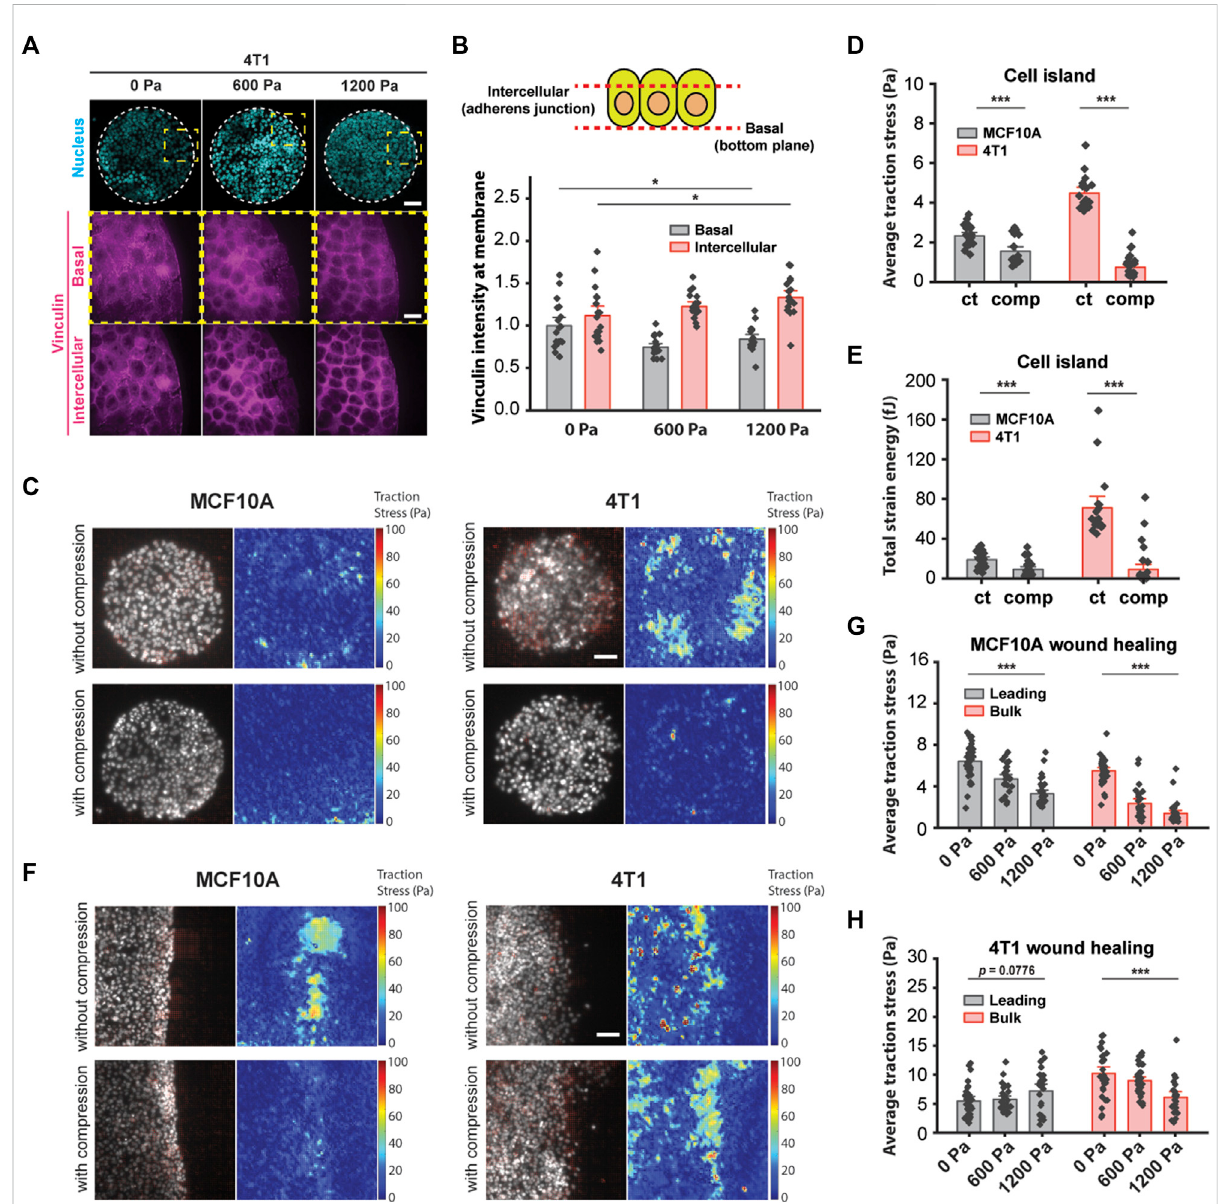
FIGURE 5 Compressive stress reduced traction stresses within the bulk cell sheet. (A) Representative microscopy images of 4T1 cell islands labeled with DAPI and a vinculin antibody. Vinculin staining is shown at two different imaging planes. Micropatterned cell islands were exposed to speci fi ed pressuresfor12 h.Scalebars,80 µm(top)and20 µm(bottom). (B) Quanti fi cationofrelativevinculinintensityofindividualcellsatthebasalplaneand at intercellular junctions. Mean fl uorescence ±S.E. is plotted from three independent replicates ( n = 18). (C) Traction stress vector fi eld and traction stress magnitude of micropatterned cell islands with and without 1,200 Pa compression for 3 h. Cell nuclei are labeled with Hoechst 33342. Scale bar, 80 µm. Mean traction stresses (D) and total strain energy (E) with and without compression on micropatterned islands. Number of images analyzed for MCF10A: control ( n = 21) and compressed ( n = 21). Number of images analyzed for 4T1: control (n = 18), compressed ( n = 30). (F) Traction stress vector fi eld and traction stress magnitude of a wounded edge with and without 1,200 Pa compression for 3 h. Cell nuclei are labeled withHoechst33342.Scalebar,80 µm.MeantractionstressesexertedbyMCF10A cells (G) and4T1cells (H) attheleadingedge(within5 – 7celllayers of the wound margin) and within the bulk monolayer for 0, 600, and 1,200 Pa compressive stress for 3 h. Number of images analyzed for MCF10A: 0 Pa ( n = 37), 600 Pa ( n = 26), and 1,200 Pa ( n = 32). Number of images analyzed for 4T1: 0 Pa ( n = 28), 600 Pa ( n = 33), and 1,200 Pa ( n =